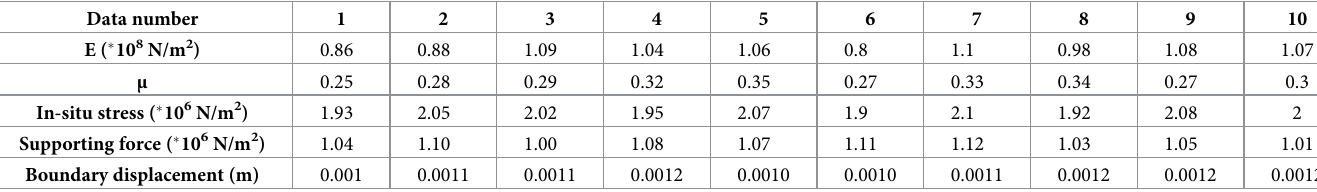
Table 1. Parameters, loads and boundary conditions of the